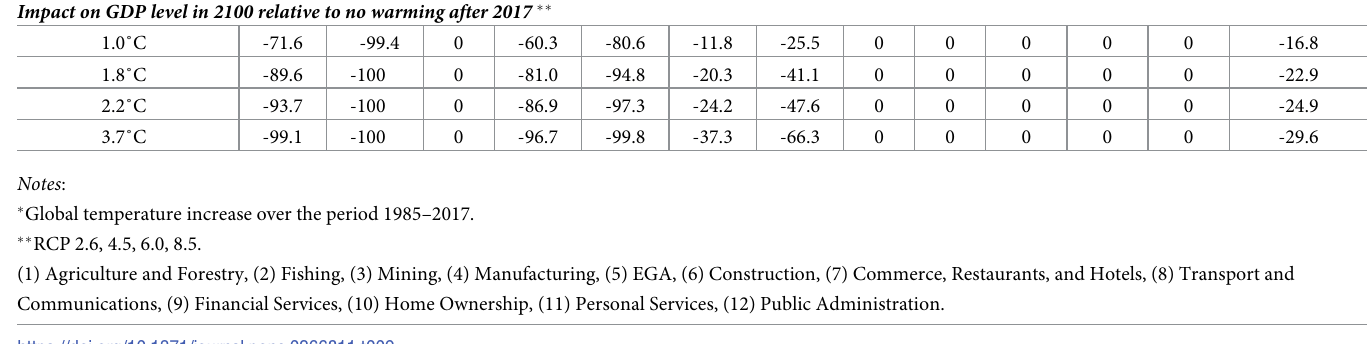
Table 9. Simulated impact of the climate change on the industry, overall GDP and growth rates in Chile: Only stat. significant coefficients with a negative value (monthly, Table 5). Temperature increase Impact on GDP growth rate in 2017 relative to no warming after 1985 �� 0.26˚C � Impact on GDP level in 2050 relative to no warming after 2017